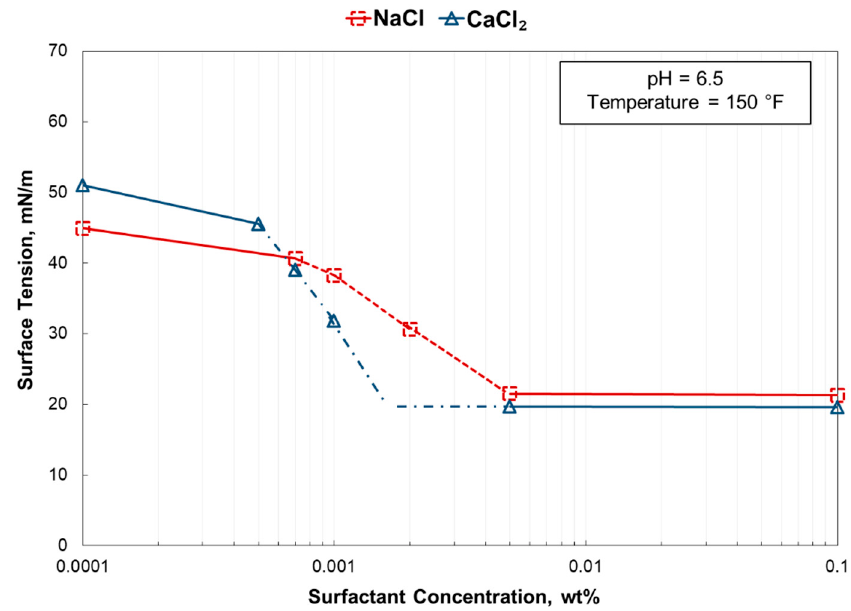
Figure 19. Surface tension as a function of surfactant concentration for 0.9 mol/kg solutions of NaCl and CaCl 2 at pH 6.5 and 150 °F (65 °C).